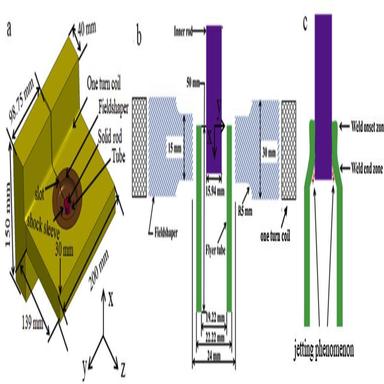
Schematic of MPW process: (a) 3D isometric projection view of the MPW platform, cross-sectional views of welding configuration (b) before welding and (c) during welding propagation.